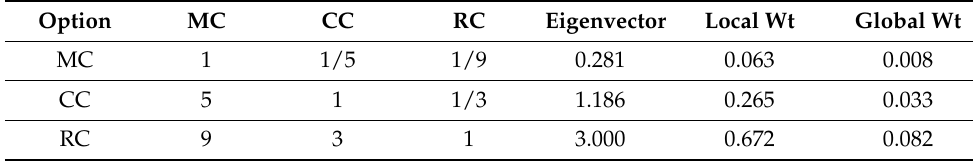
Table A9. Comparison of alternatives matrix for subcriterion